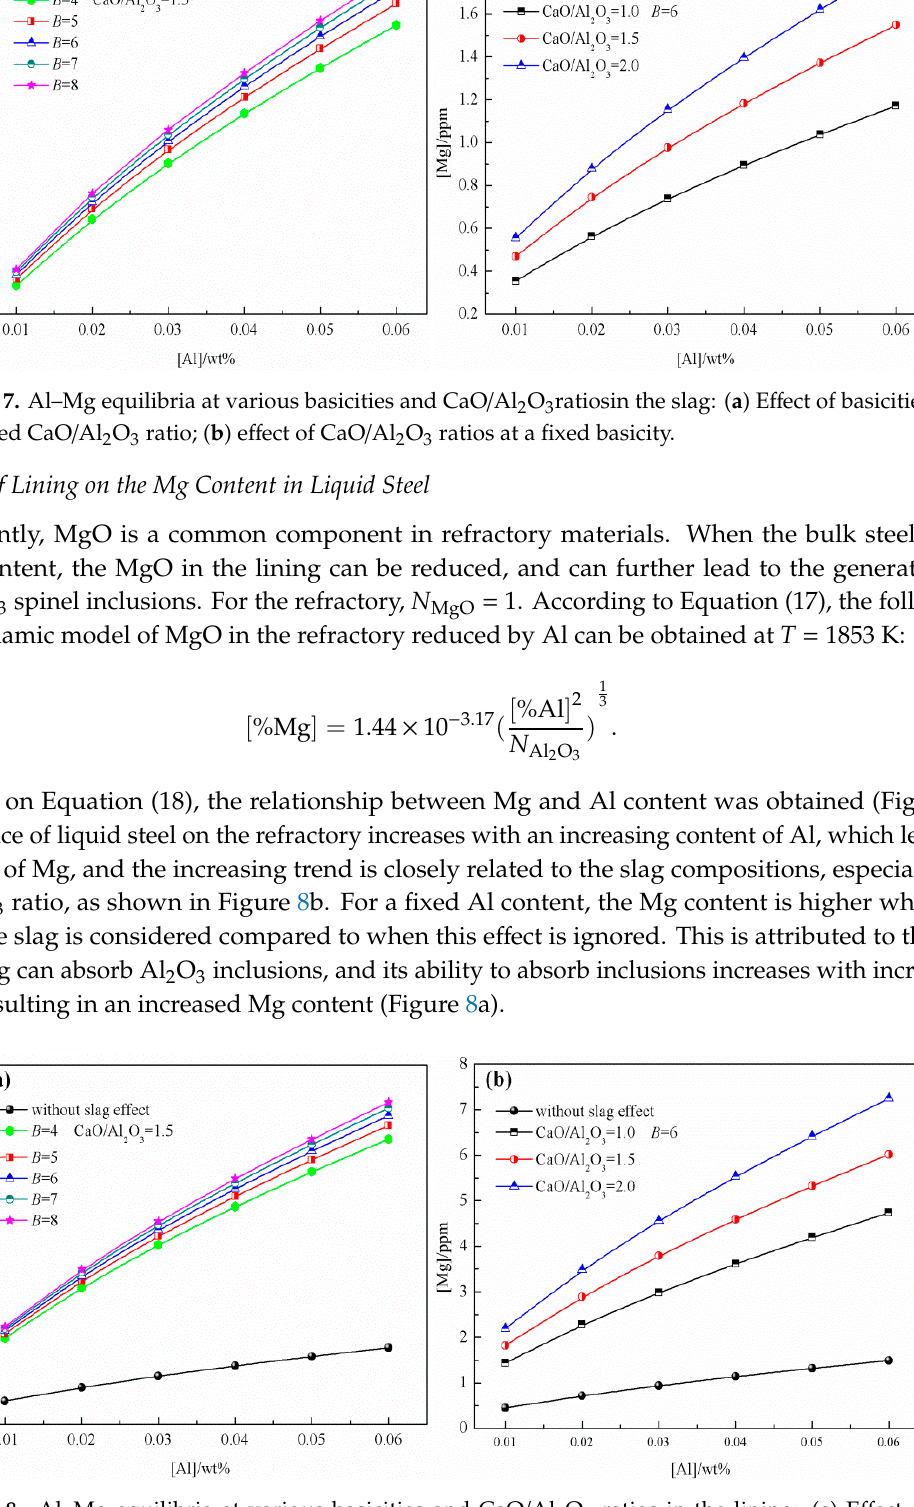
Figure 8. Al–Mg equilibria at various basicities and CaO/Al 2 O 3 ratios in the lining: ( a ) Effect of basicities at a fixed CaO/Al 2 O 3 ratio; ( b ) effect of CaO/Al 2 O 3 ratios at a fixed